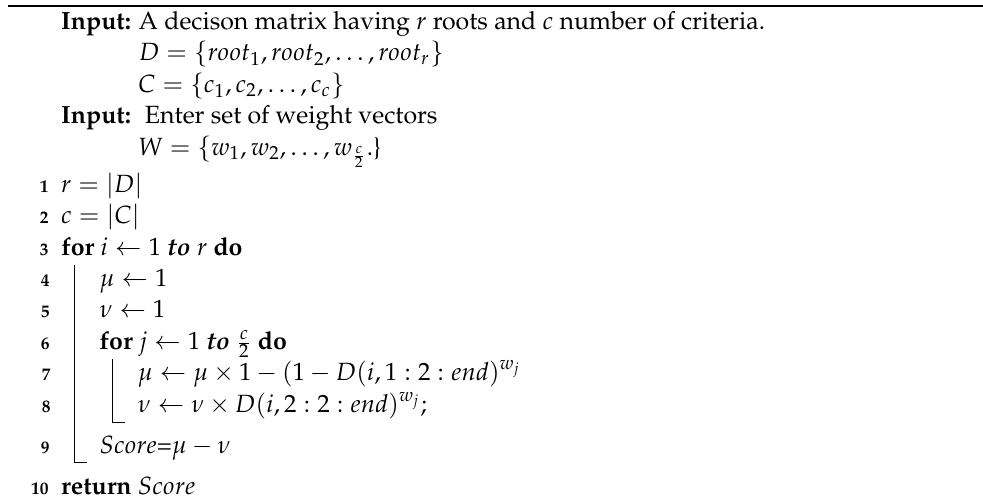
Algorithm 2: Working of IFWA operator to select optimal route